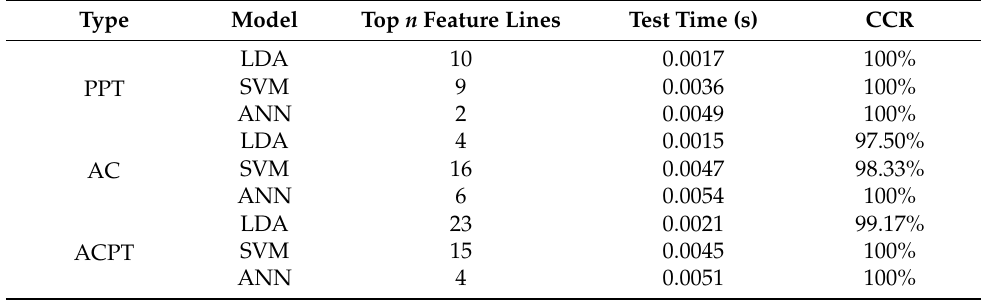
Figure 4. Test set classification accuracies of RF-LDA, RF-SVM and RF-ANN models for the three types of penicillin samples (( a ) PPT, ( b ) AC and ( c ) ACPT) with different numbers of characteristic spectral lines. Table 3. The best classification accuracy and corresponding analysis time of each model.